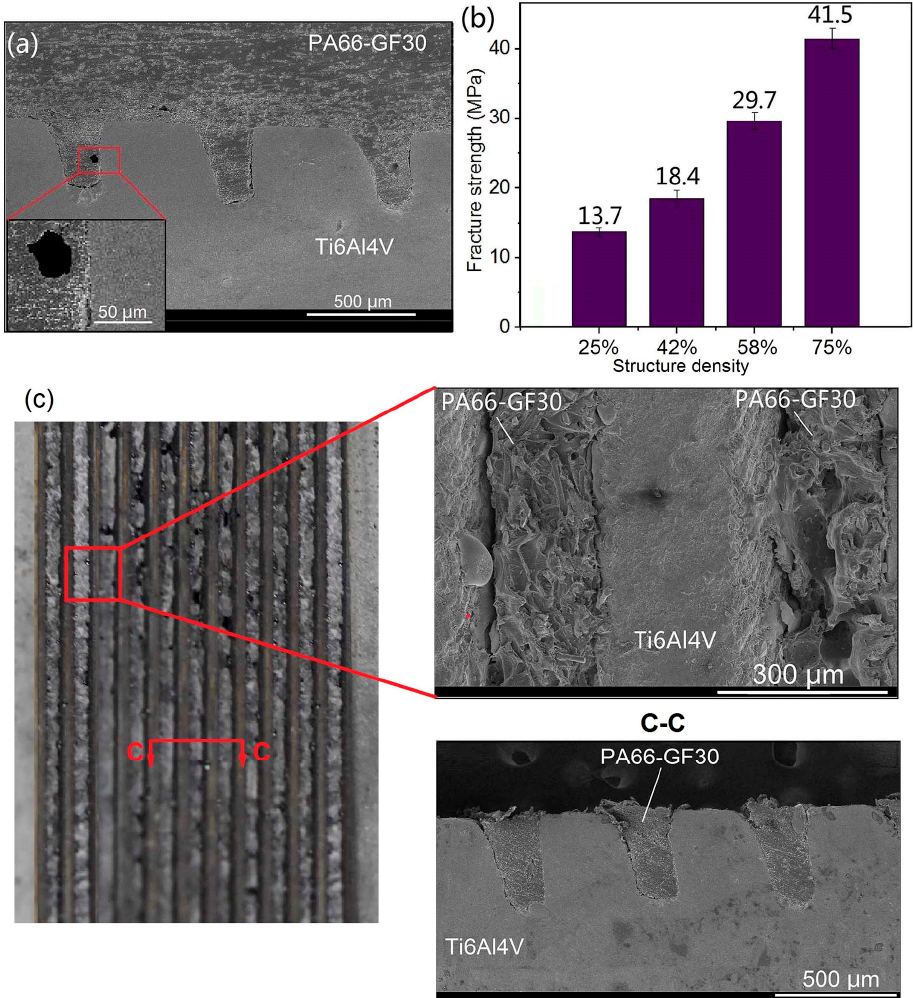
Figure 5. Cross-sections and fracture strength of Ti6Al4V-PA66-GF30 joints produced by modified laser joining process. ( a ) Cross-section of the produced Ti6Al4V-PA66-GF30 joints; ( b ) fracture strength of Ti6Al4V-PA66-GF30 joints as a function of structure density; ( c ) surface and cross morphologies of Ti6Al4V-PA66-GF30 joint after tensile shear test.